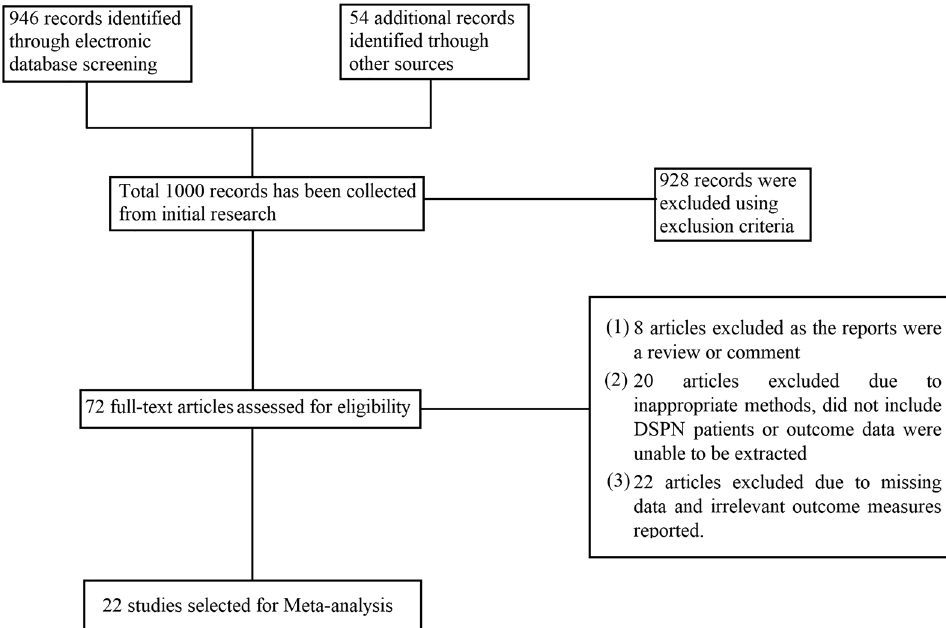
Figure 1. Study selection process for